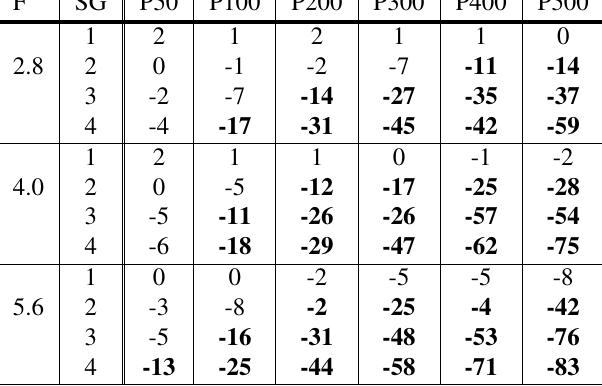
edge detector, the pupil boundary cannot be extracted ro- bustly. In addition, the induced edges by the particles them- selves connected to the pupil edge make the ellipse fit much harder. Therefore, further improvements to the algorithms should inspect automatic threshold adjustments. In addi- tion, preliminary image refinement steps are necessary since thresholding is not appropriate for light gradients over the